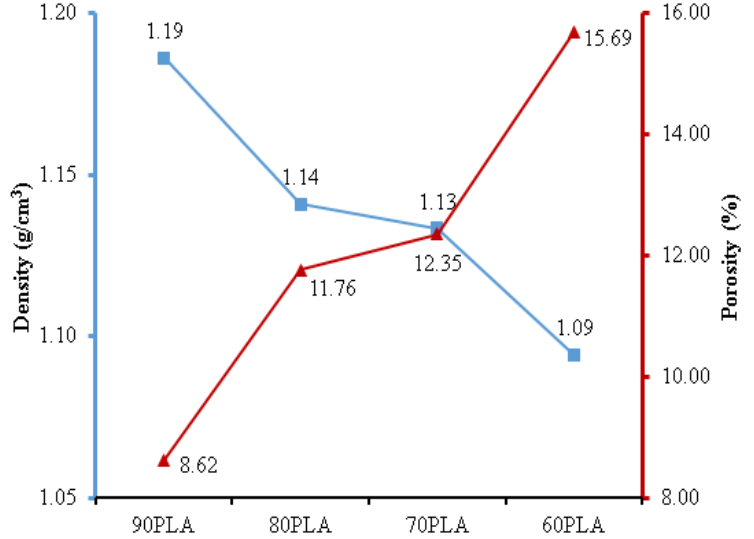
Figure 5. The density and porosity of PLA/PCL blends.